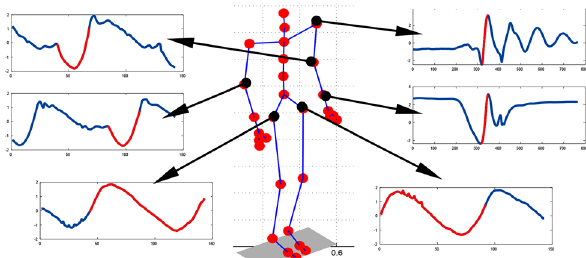
Fig. 4 Examples of similar subsequences (red curves) which are found among different body joints and in different temporal locations related to a skeleton-based action